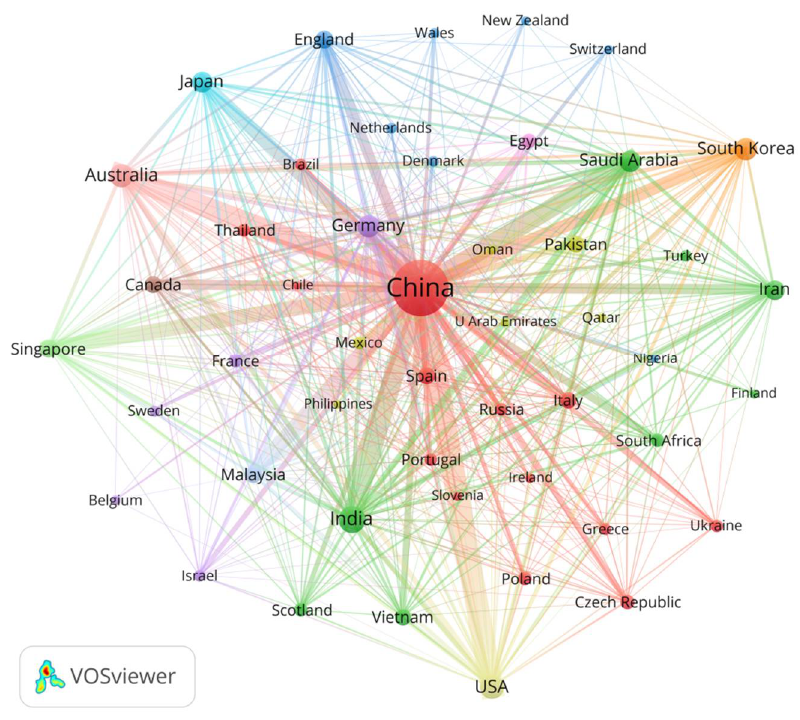
Figure 5. Countries/regions collaboration network of photocatalytic applications of g-C 3 N 4 .